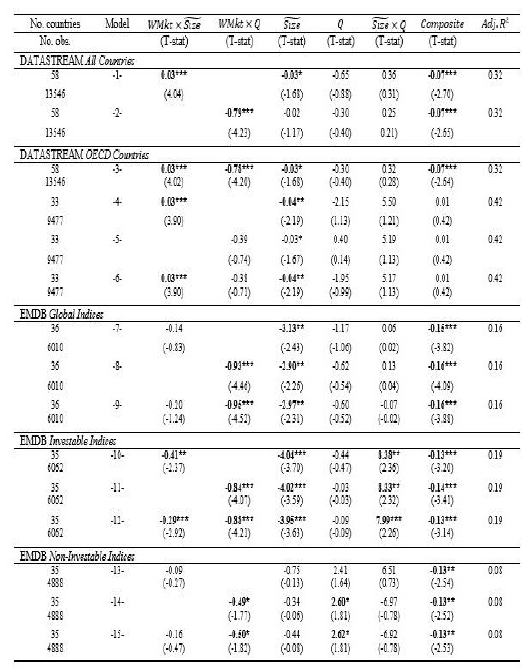
Table 10: Size and Segmentation Effects, with Country Specific and Time-Varying World